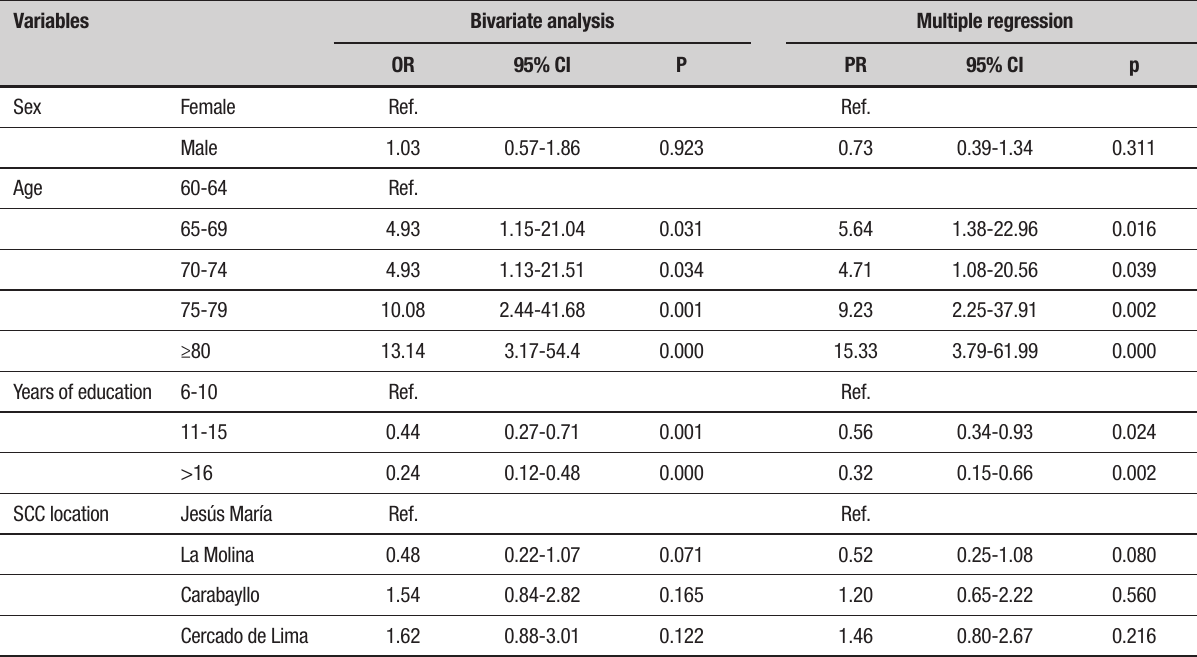
Table 3. Factors associated with presence of aMCI, determined by bivariate analysis and multiple regression (n=352). Variables Bivariate analysis